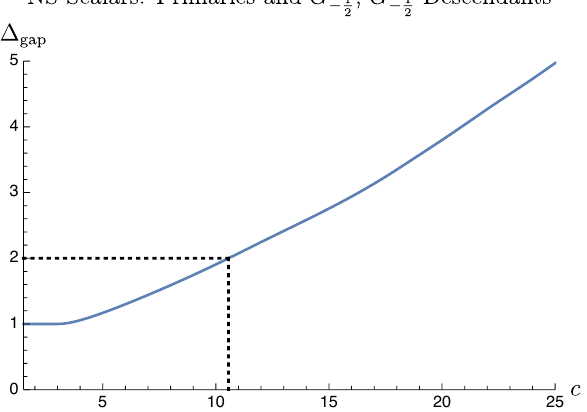
Figure 6: Upper bounds on the gap in the NS spectrum of scalar op- erators that are either super-Virasoro primaries or G − 1 dants (of fermionic superconformal primaries), as the central charge is varied up to c = 25. The range of c in which the bound is below 2, marked by the dashed lines, indicate the necessary existence of a relevant deformation.